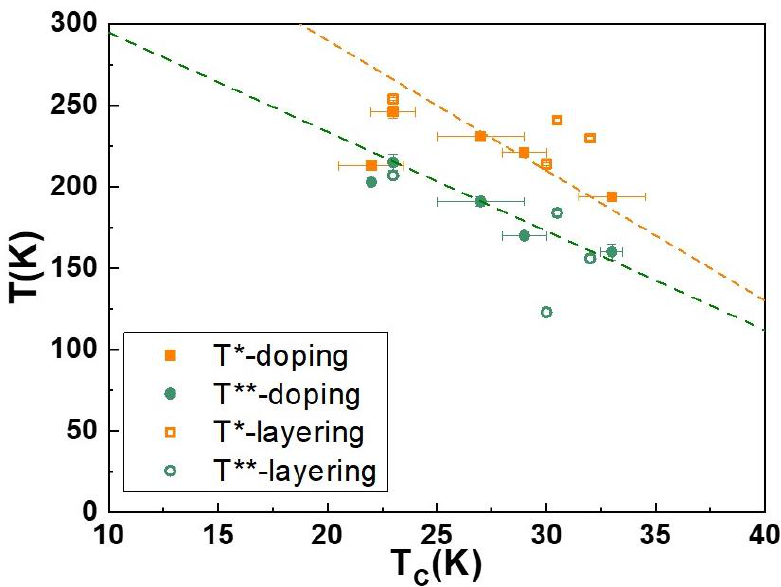
Figure 4. T* and T** values for the SLCO films and trilayers as a function of T Conset . The dotted lines are guides for the eyes.